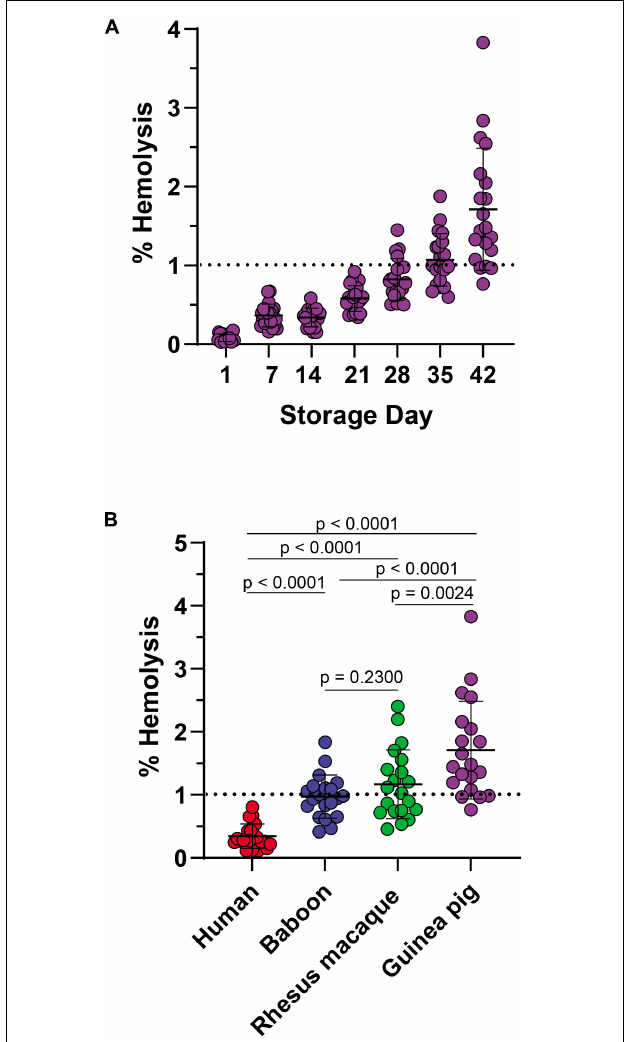
FIGURE 8 | Impact of storage duration on guinea RBC hemolysis (A) and comparison to end-of-storage hemolysis in baboons, macaques, and humans (B)